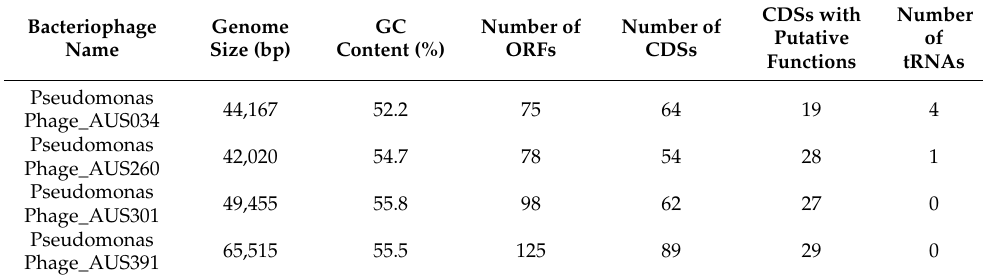
Table 8. Characteristics of the genomes of the isolated